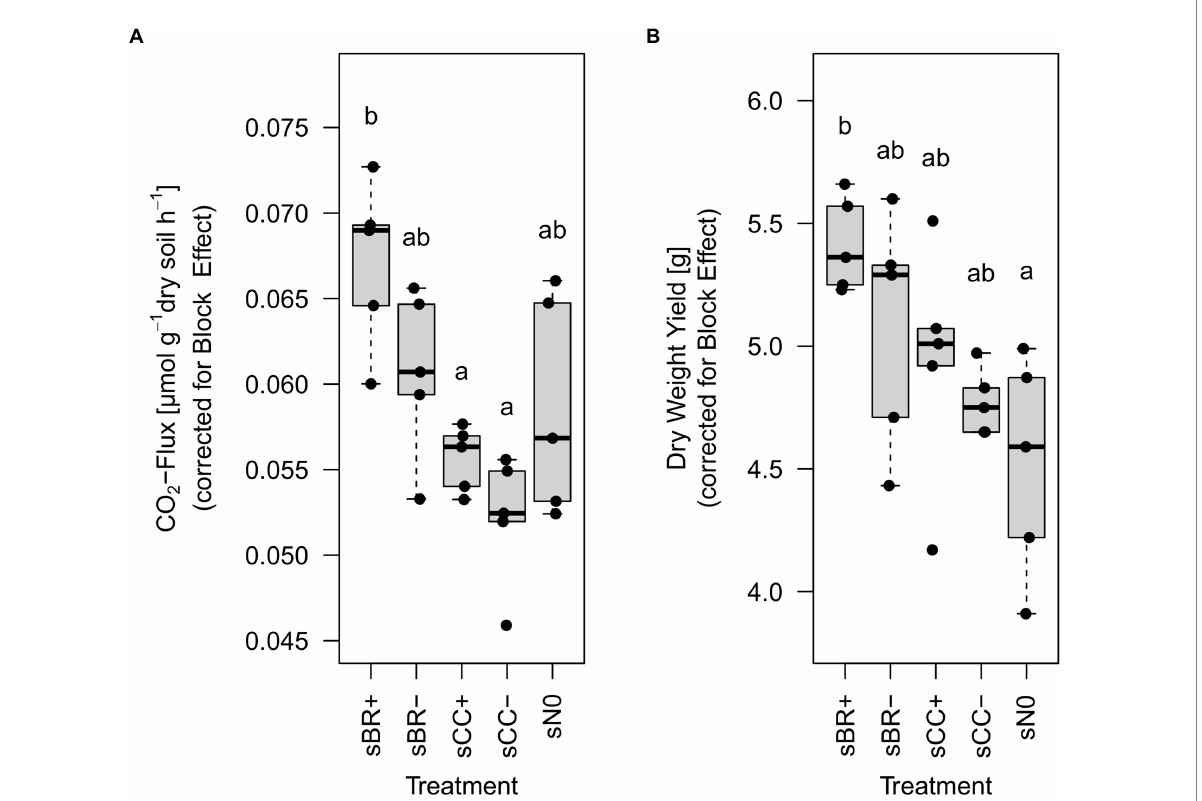
FIGURE 4 Basal respiration (A) and grass-clover dry weight yield (B) at the end of the experiment (day 42) from the different fertilizer amended soils. Distinct lower-case letters indicate significant ( p < 0.05), n = 5 differences among treatments as determined by Tukey’s HSD test, values were corrected for the significant block effect as determined by ANOVA. sBR+, soil fertilized with BSFL residue; sBR-, soil fertilized with sterile BSFL residue; sCC+, soil fertilized with conventional compost; sCC-, soil fertilized with sterile conventional compost; sN0, no-fertilizer